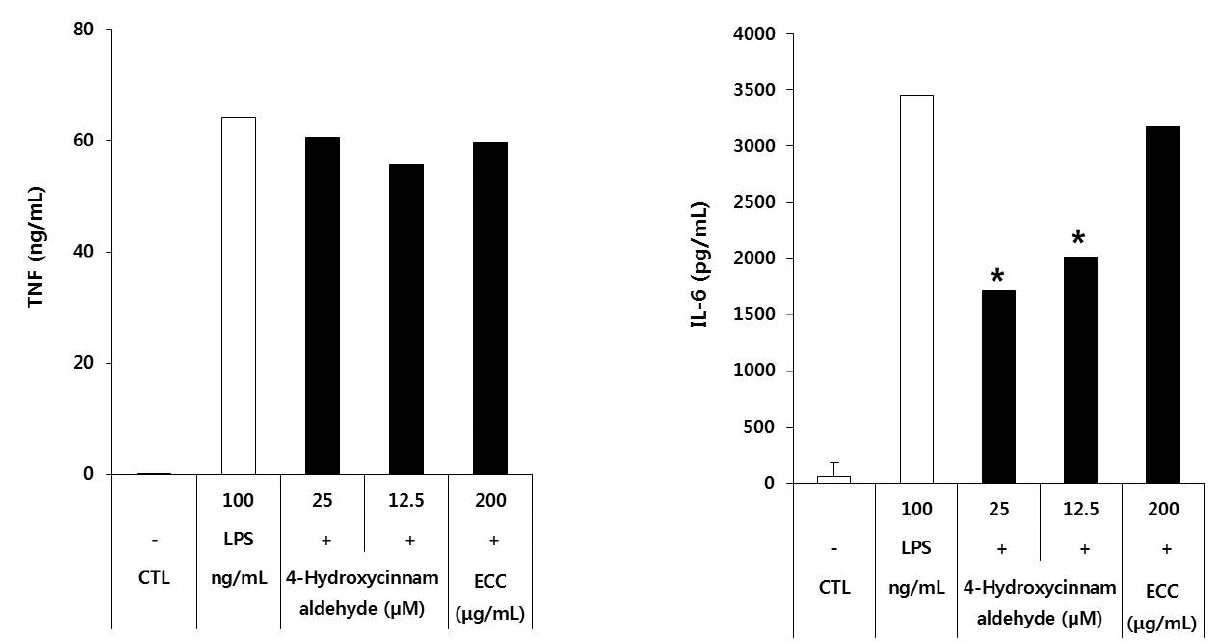
Figure 5. Inhibitory effect of ECC and 4-hydroxycinnamaldehyde on the production of cytokines TNF and IL-6. TNF and IL-6 in the culture supernatant were detected using ELISA. The data are presented as the means ± SD of three independent experiments. * p < 0.05 compared to the LPS group.